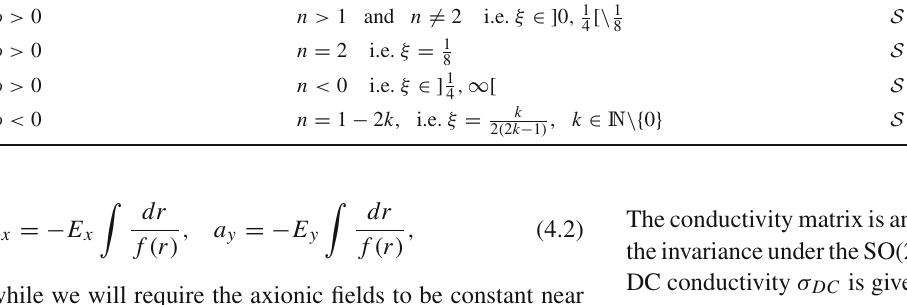
Table 2 Signs of the entropy and mass of the dyonic solutions whose reality conditions are fixed by Table 1 and where b 0 = Sign of ω Permissible values of ξ Signs of entropy and mass ω > 0 n > 1 and n (cid:12)= 2 i.e. ξ ∈ ] 0 , 1